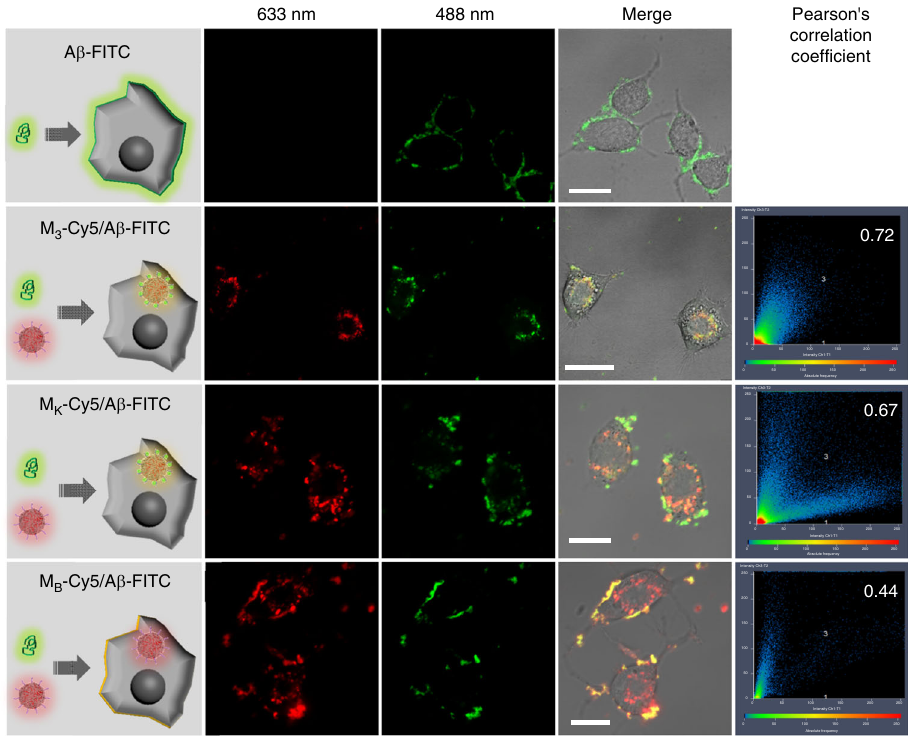
Fig. 4 A β was internalized into cells with M 3 nanosweeper. Schematic (row 1) and CLSM measurements of N2a cells treated with A β , a mixture of A β /M 3 , A β /M K and A β /M B (row 2, 633 nm; row 3, 488 nm; row 4, Merge). Scale bar: 20 µ